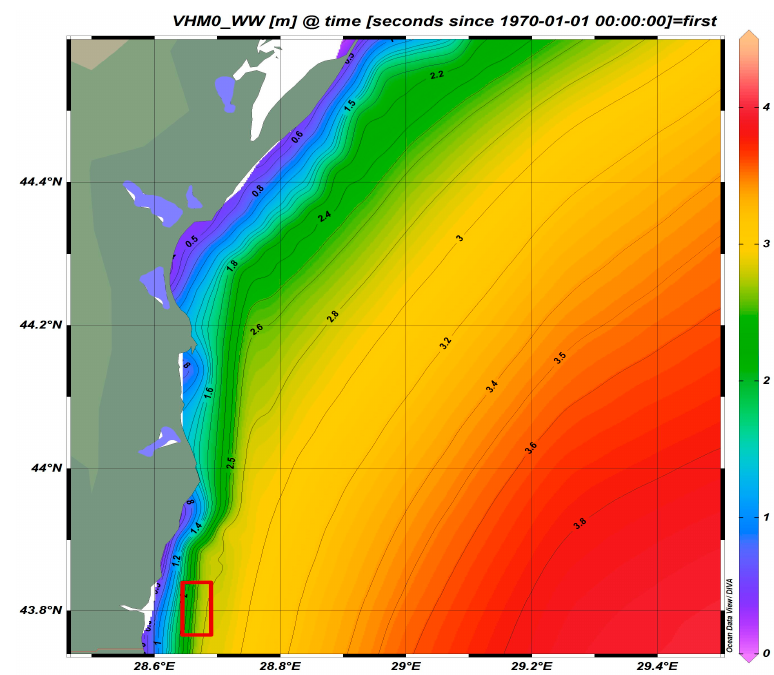
Figure 4. Spectrally significant wind wave height in the Mangalia area, Romania.